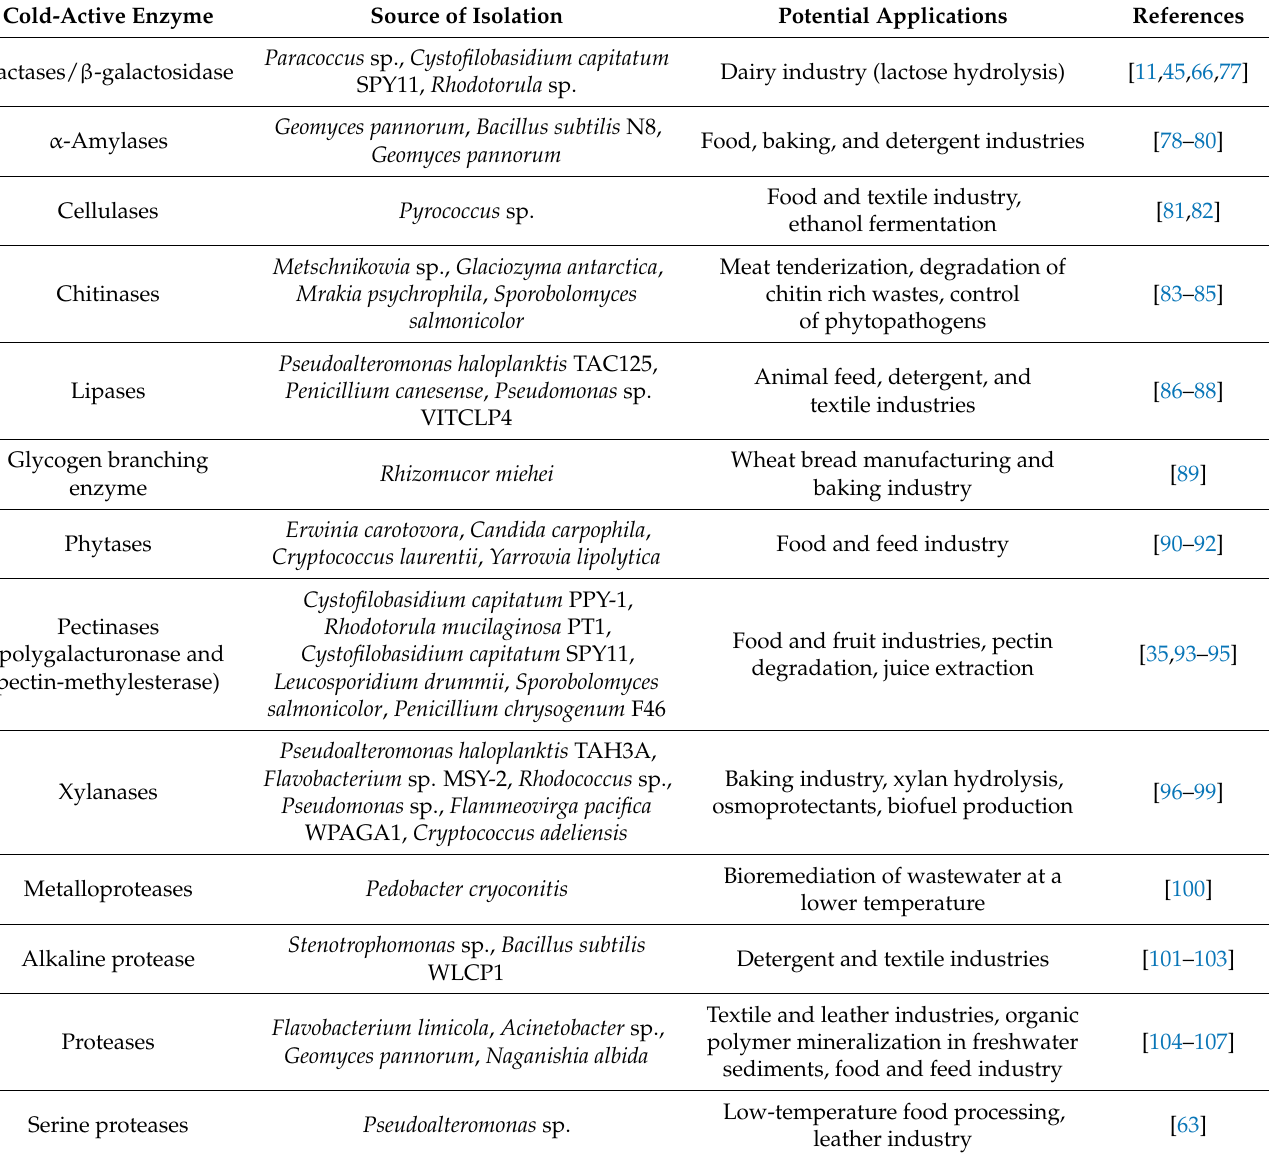
Table 1. List of some cold-active enzymes and their potential industrial